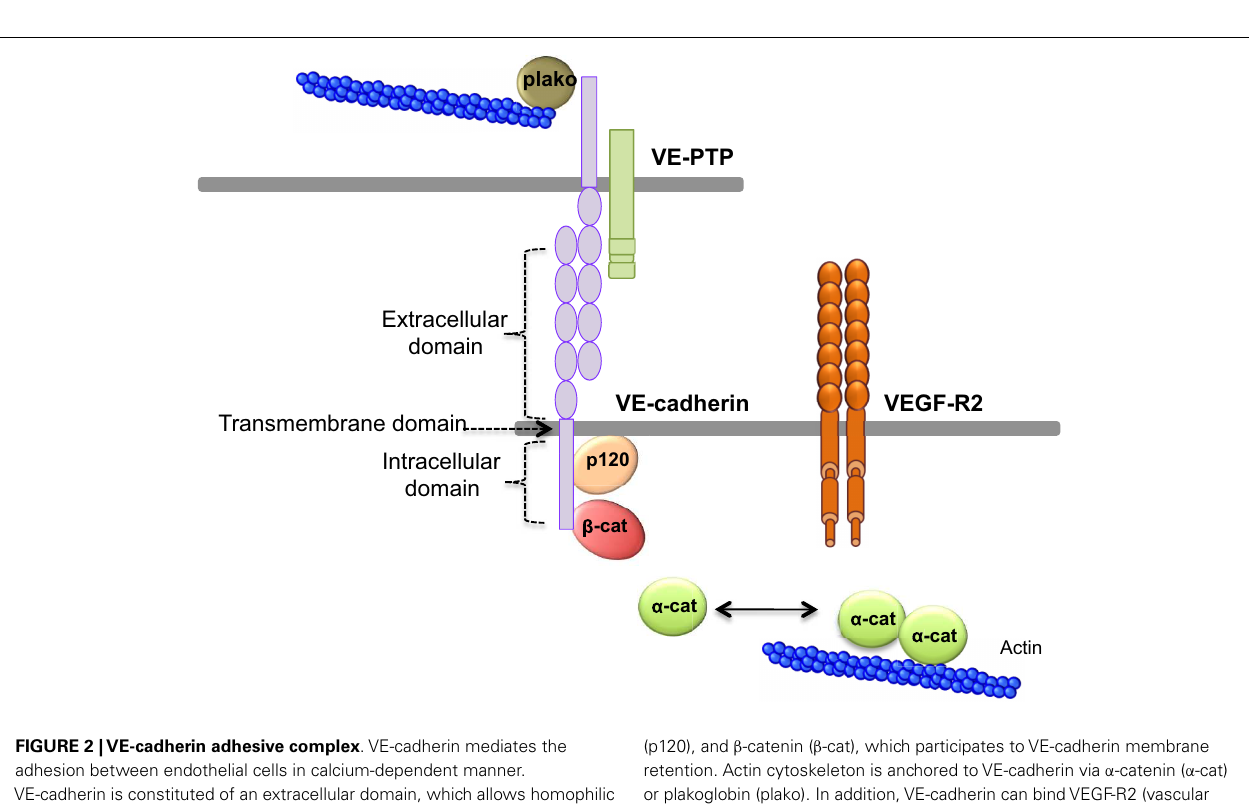
FIGURE 2 |VE-cadherin adhesive complex .VE-cadherin mediates the adhesion between endothelial cells in calcium-dependent manner. VE-cadherin is constituted of an extracellular domain, which allows homophilic interaction in trans .The transmembrane domain participates to lateral clustering in cis. The intracellular domain ofVE-cadherin binds p120-catenin